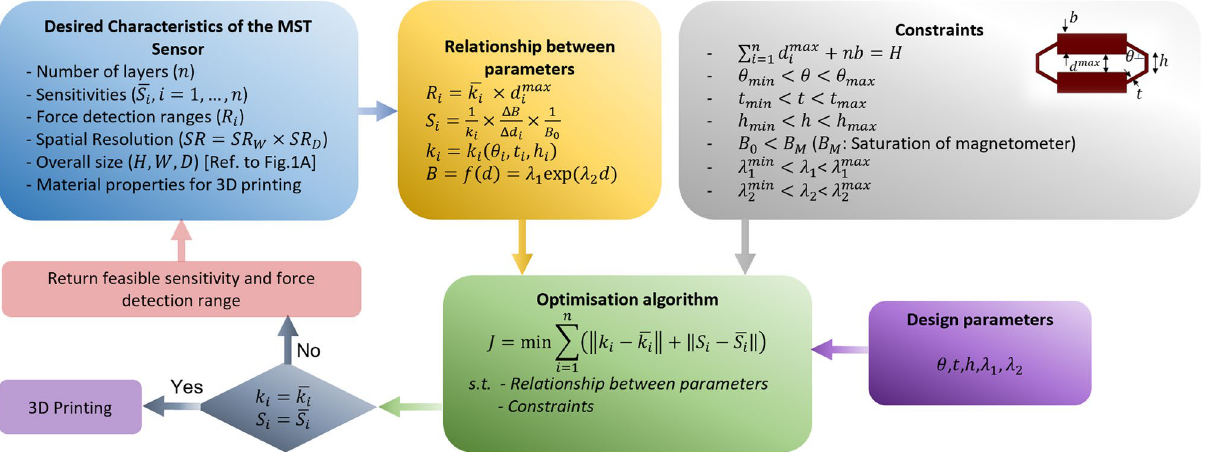
Figure 3. The design framework of the MST sensor. Given the desired characteristics of the sensor, this design procedure will provide the design parameters of the sensor